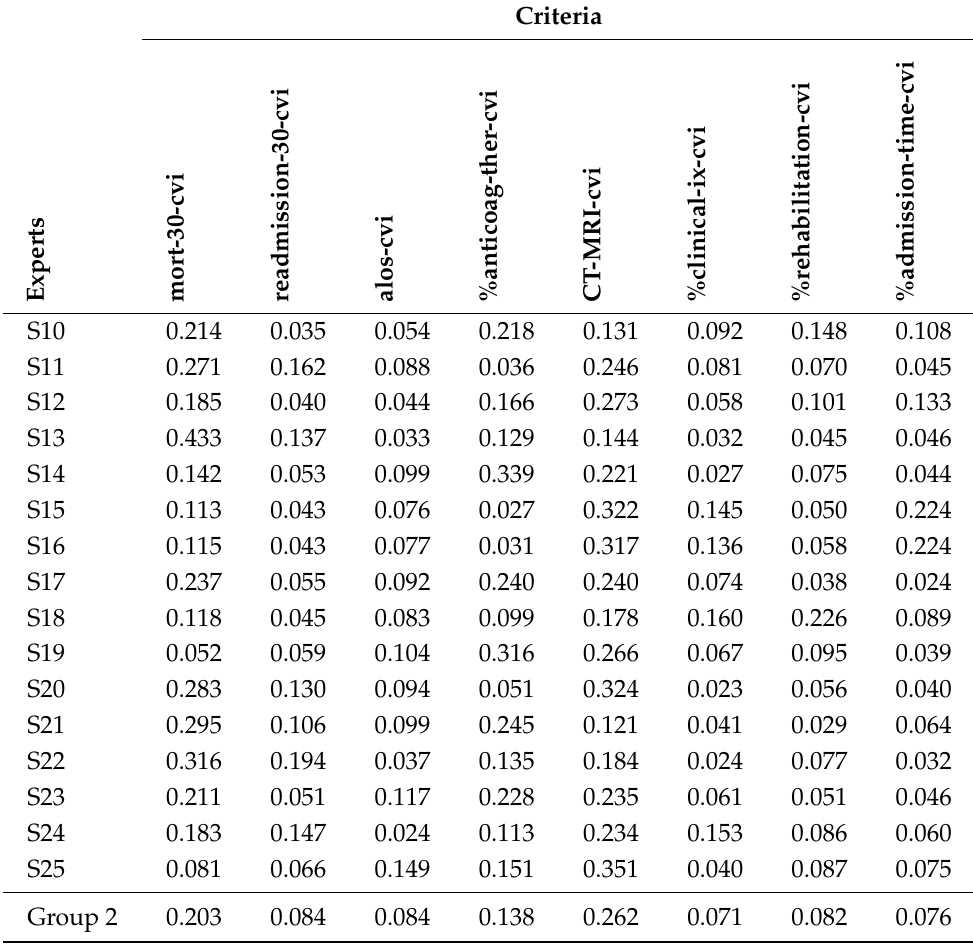
Table 8 presents individual and the group criteria weights. The group criteria weights were used for hospital rankings. Table 8. CVI criteria weights based on individual comparison matrices, and the group criteria weights. (S1 to S9 indicate experts participating in the AHP exercise).